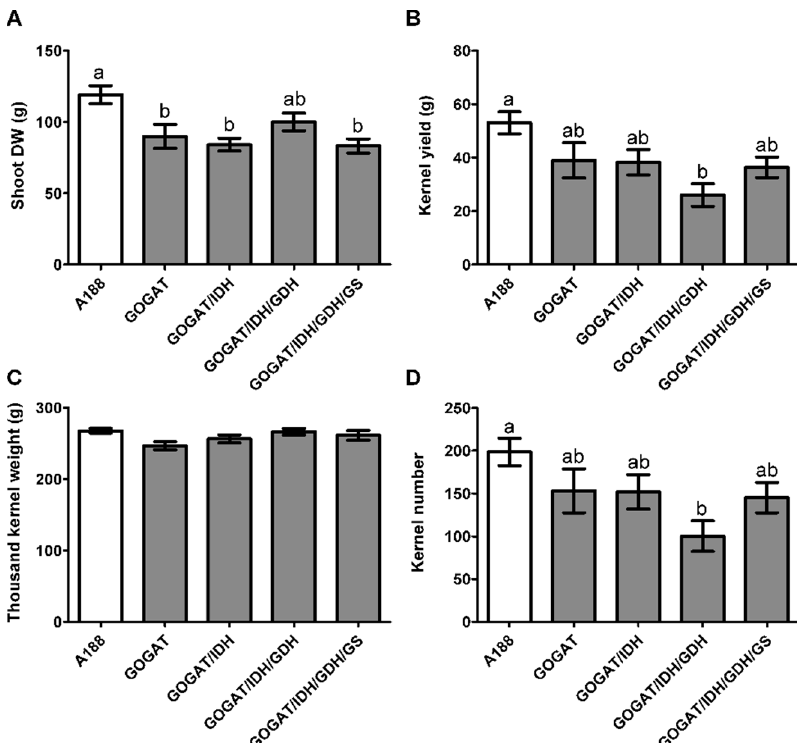
Figure 2. Shoot biomass production and yield-related traits in WT and transgenic plants modified for 2-Oxoglutarate production and ammonium assimilation. The white column corresponds to the WT plants (A188). The grey columns correspond to transgenic line overexpressing NADH-GOGAT (construct T02291) and NADH-GOGAT stacked with NAD-IDH (construct T02289), NAD-IDH + NADH-GDH1 (construct T02308) and NAD-IDH + NADH-GDH1 + GS1.3 (construct T02312). Shoot dry weight, ( A ). Kernel yield, ( B ). Thousand kernel weight, ( C ). Kernel number, ( D ). The error bars correspond to standard error (SE). Data were analyzed with a one-way ANOVA and the Newman-Keuls comparison test. The di ff erent letters (a, b) on top of the columns indicate significant di ff erences at p ≤